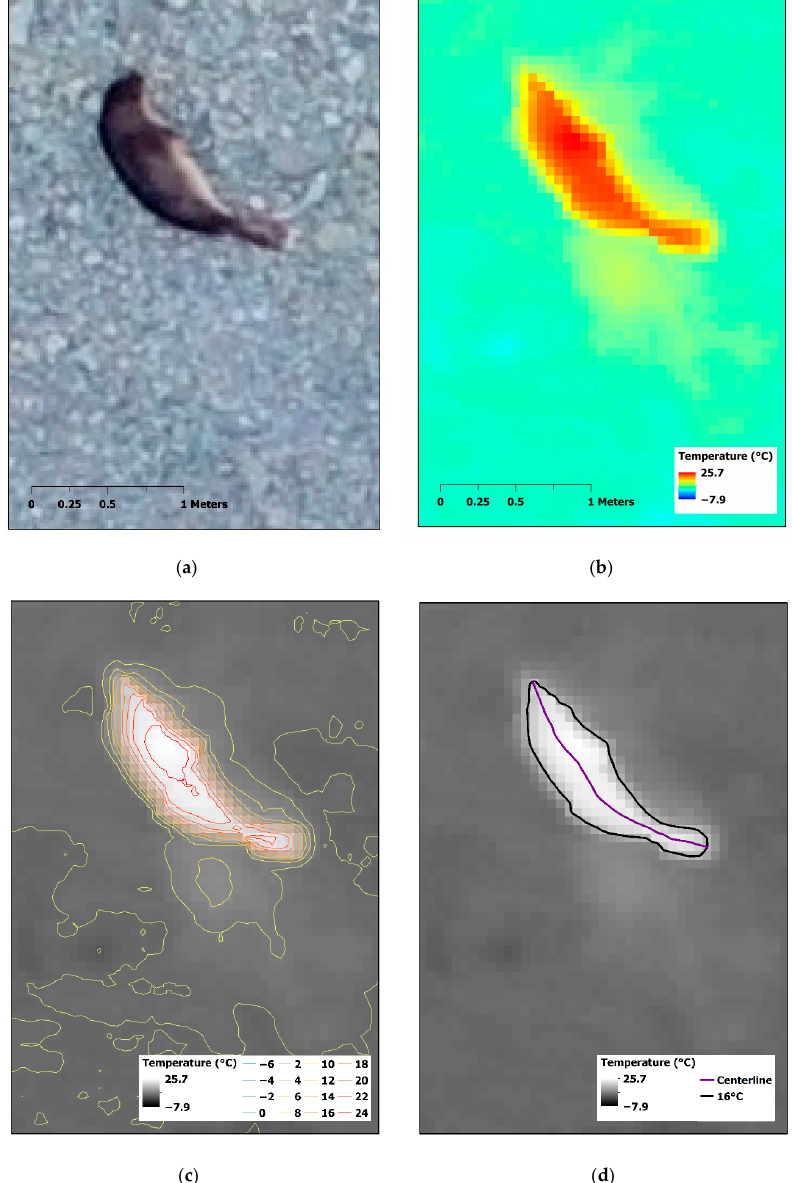
Figure 5. Mosaicked RPAS-based RGB and thermal images zoomed to a Southern elephant seal ( Mirounga leonina ): ( a ) zoomed RGB image, ( b ) zoomed coregistered thermal image, ( c ) temperature contours with 1 ◦ C interval overlaid on thermal image, and ( d ) selected contour of 16 ◦ C depicting the highest thermal contrast and centerline of the polygon indicating an individual